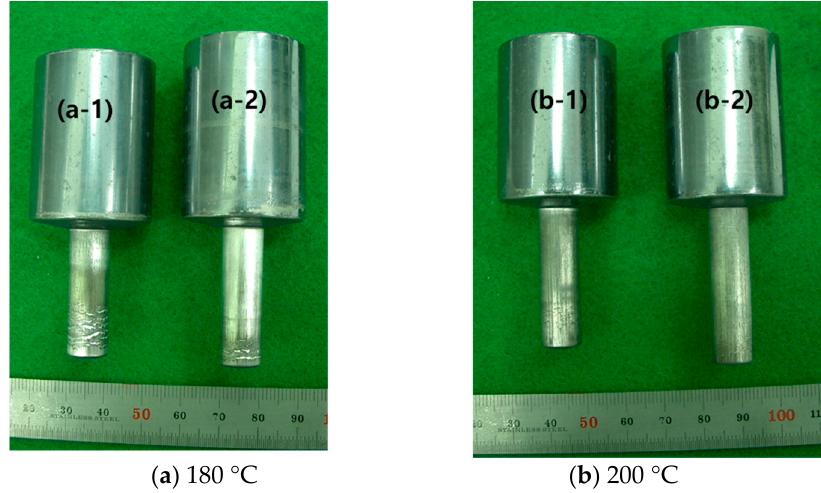
Figure 3. Extruded specimens at the forming temperature of ( a ) 180 °C and ( b ) 200 °C under the punch speed of (1) 2 mm/s, (2) 20 mm/s for FER = 9.0 and BER = 4.02.